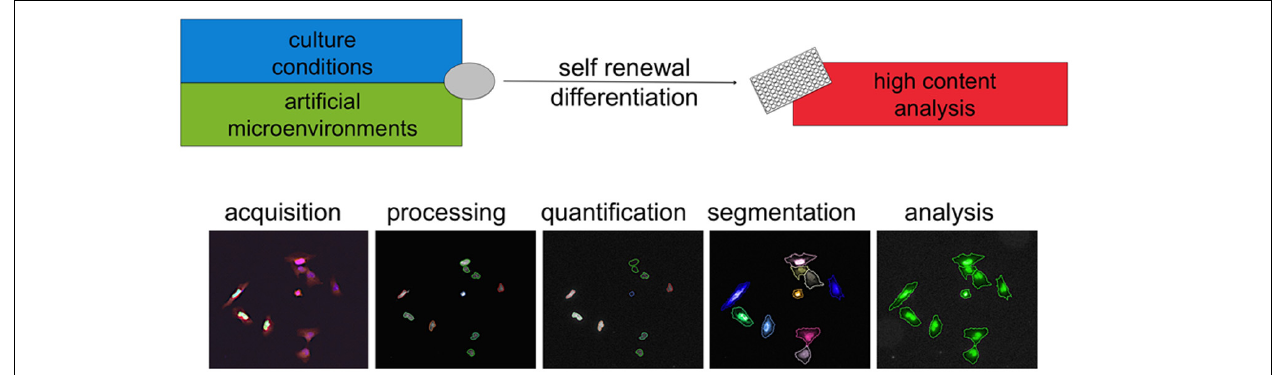
FIGURE 3 | High content analysis. High content analysis involves a series of steps to convert images into data. Cells in different conditions are imaged via microscopy. Images are then processed (for example in contrast) and then analyzed using computer algorithms. Segmentation refers to the definition based on pixels intensity of “objects” such as cells, nuclei, or other subcellular structures. Via cytochemistry, the expression of specific markers can be elicited and the levels